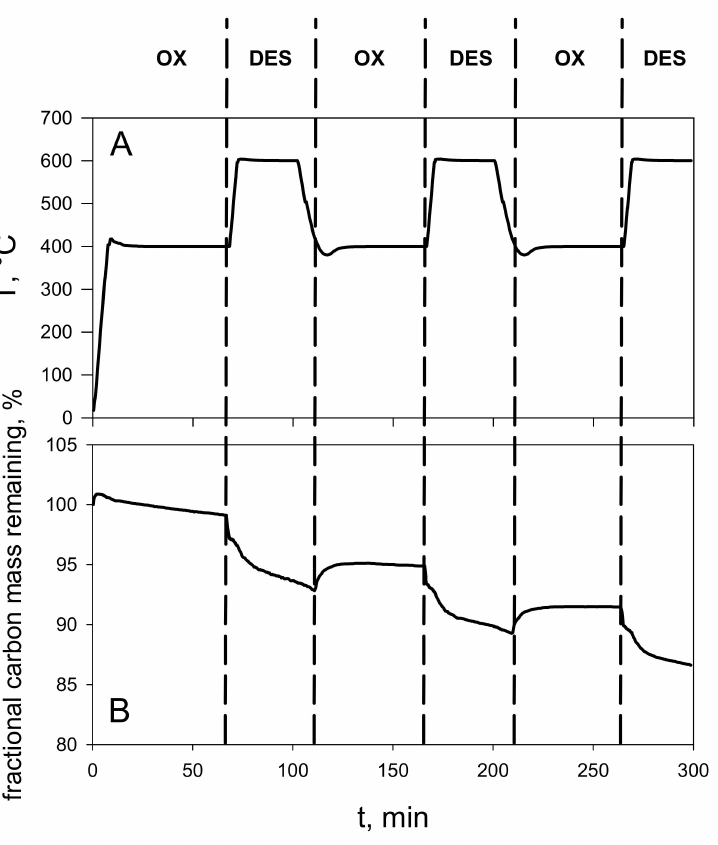
Figure 2. ( B ): Mass profiles.